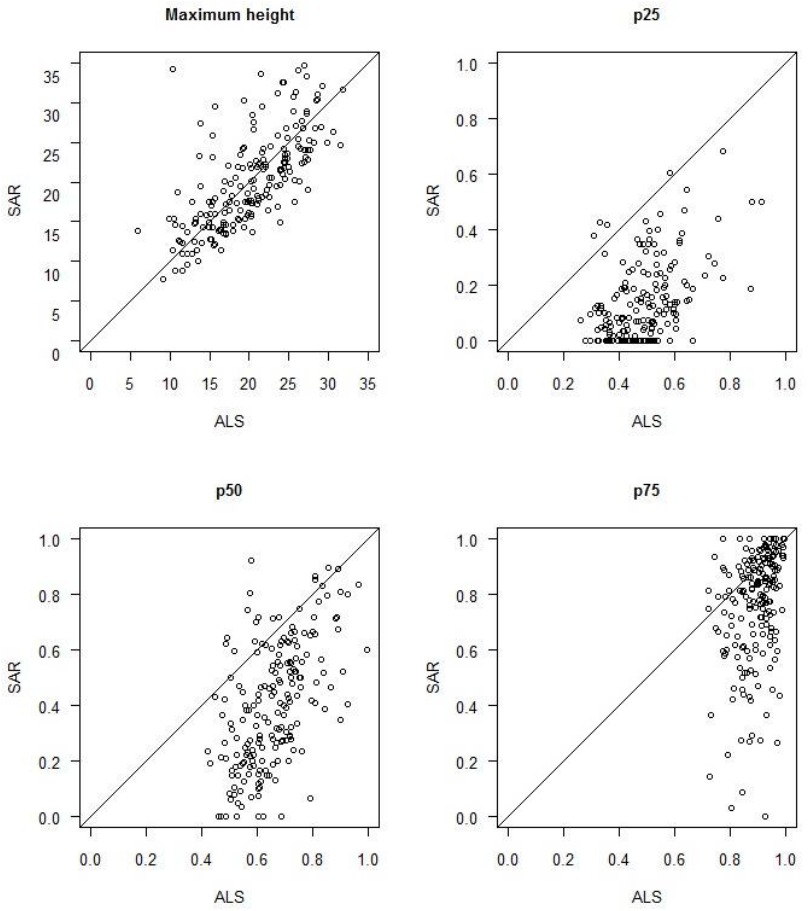
Figure 2. Plot-level maximum point heights and proportions of the points below a 25%,